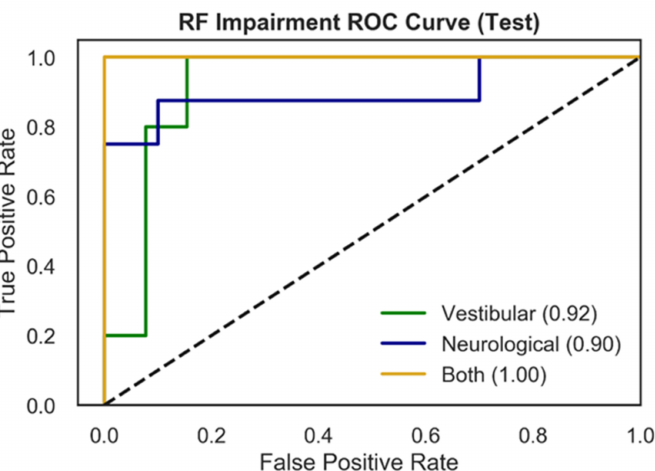
Figure 3. ROC curves for multiclass impairment prediction using the RF model and NTS prepro- cessing pipeline. Each curve represents the specific impairment vs. the rest of the classes (one vs. rest) and depicts the trade-off between True Positive Rates (TPR) and False Positive Rates (FPR) for each physiological impairment condition. The ROC performance is based upon the optimal threshold selected by the model for the testing set. The three colored curves correspond to vestibular impairment = green, neurological impairment = blue, both = yellow. The dotted black line represents random